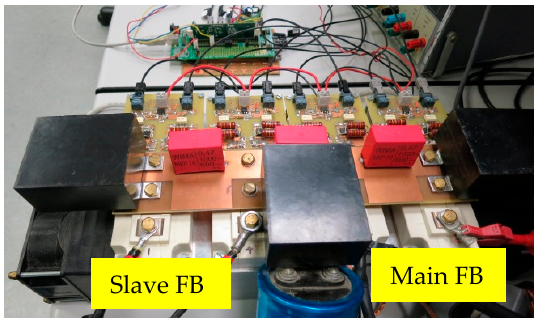
Figure 13. LCC resonant multilevel converter.